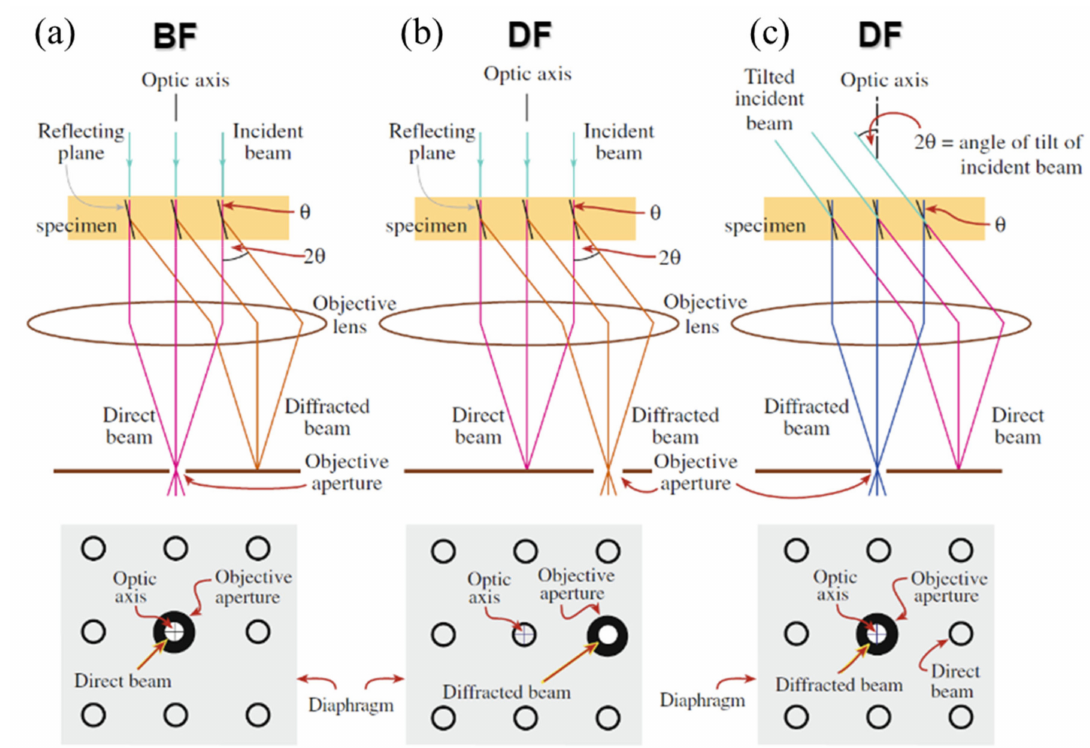
Figure 8. Ray diagrams demonstrating the formation of BF, DF, and centered DF images by selecting specific beams in the diffraction plane with the objective aperture and reforming the filtered image at the imaging plane. ( a ) BF images are produced by selecting the direct beam while both ( b ) DF and ( c ) centered DF images are formed by filtering out the direct beam, using only one or more diffracted beams to form the image. Centered DF images are formed by tilting the incident beam so that the diffracted beam aligns with and is centered on the optic axis, which reduces aberrations. The bottom row shows the region of the diffraction pattern that is selected by the aperture in each case [92]. Figure 8 reprinted by permission from Springer Nature Customer Service Centre GmbH: Springer Nature, Springer eBook, Diffraction in TEM, David B. Williams, C. Barry Carter, Copyright © 2009, Springer Science Business Media New